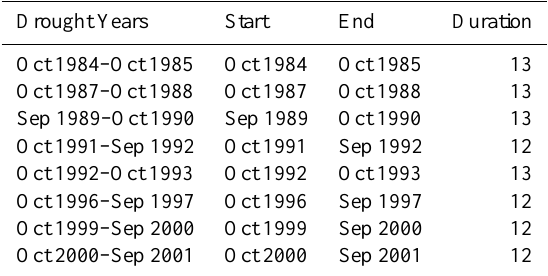
Table 5. Duration of drought episodes (in months in Thessaly). Drought Years